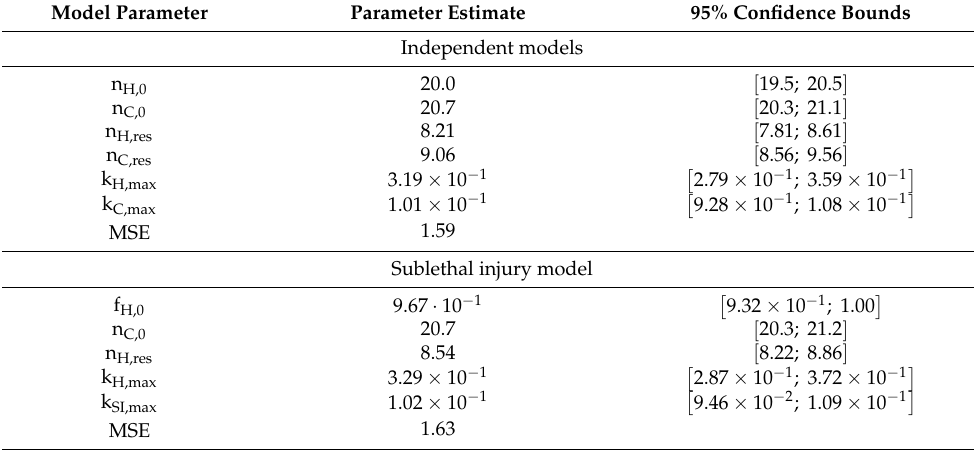
Table 3. Parameter estimation results from fitting the independent models (Equations (32) and (33)) and sublethal injury model (Equations (38) and (39)) based on log-linear inactivation with tailing on Dataset